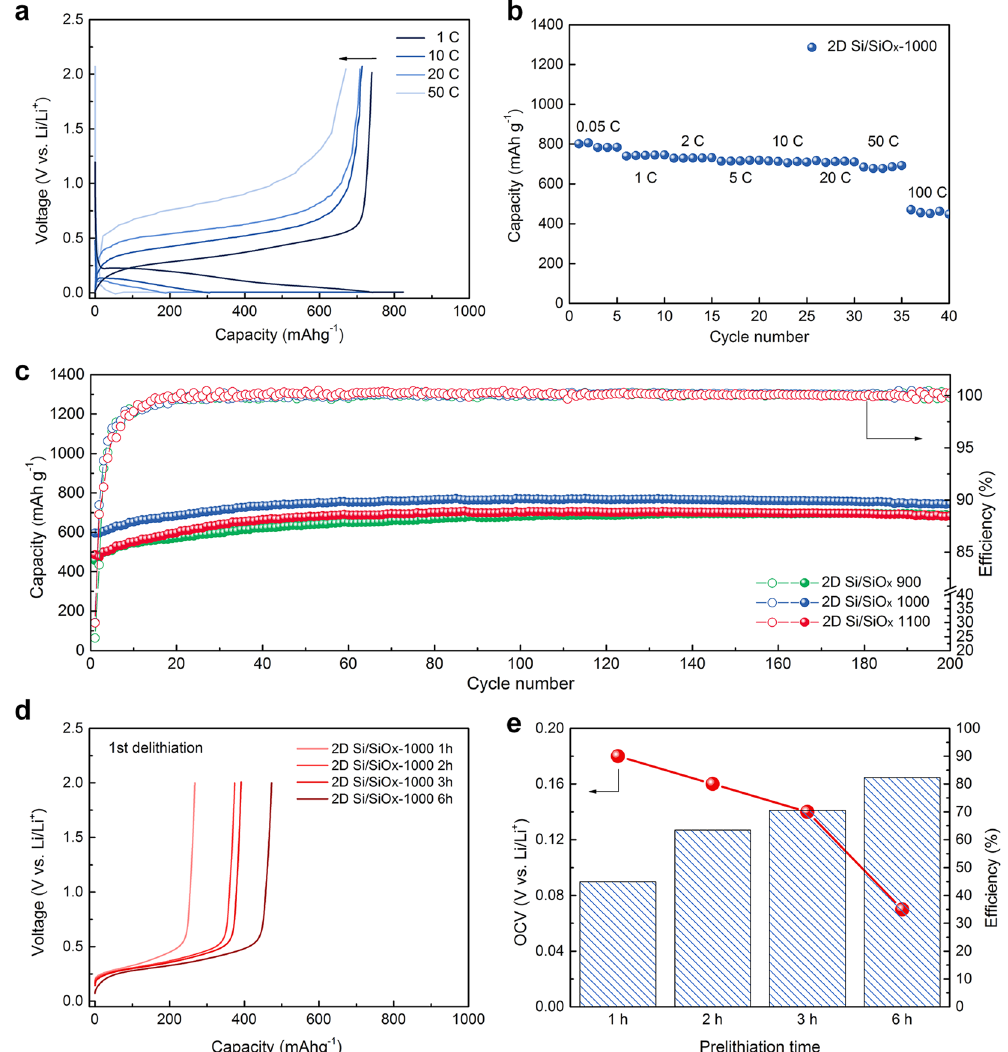
Figure 4. Electrochemical performance of 2D Si/SiO x nanofoils. ( a ) Galvanostatic voltage profiles of 2D Si/SiO x nanofoils (1000 °C) collected at different current densities of 1, 10, 20, and 50 C, ( b ) rate-capability of a Si/SiO x nanofoil (1000 °C) anode at different current densities of 0.05, 1, 2, 5, 10, 20, 50, and 100 C (1 C = 1000 mA g − 1 ), ( c ) cycling performance of 2D Si/SiO x nanofoil electrodes for samples prepared at different temperatures at a constant current of 0.2 C (200 mA g − 1 ) for 200 cycles, ( d ) discharge (Li + extraction) profiles of pre-lithiated 2D Si/SiO x nanofoil (1000 °C) electrodes at a constant current of 0.2 C (200 mA g − 1